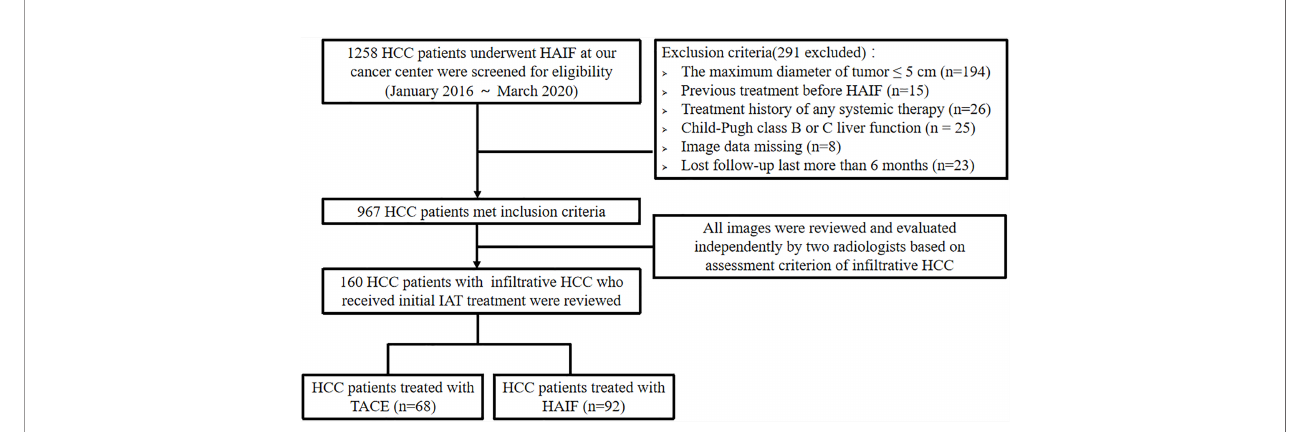
FIGURE 1 | Flow diagram showing the patients with in fi ltrative HCC enrolled in